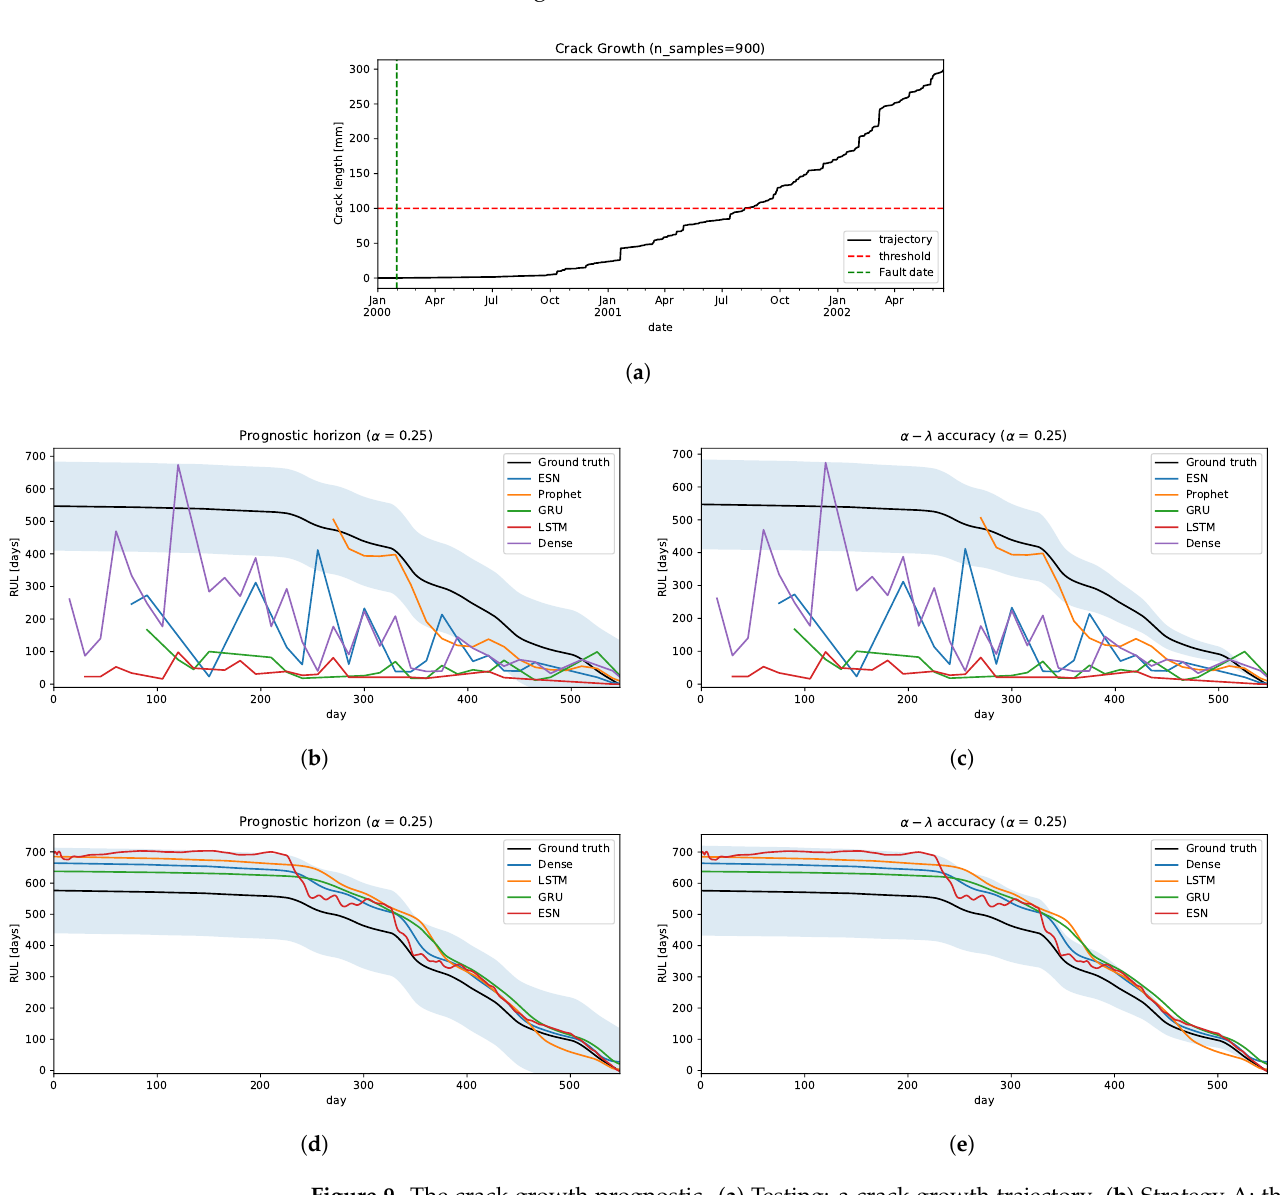
Figure 9. The crack growth prognostic. ( a ) Testing: a crack growth trajectory. ( b ) Strategy A: the prognostic horizon metric. ( c ) Strategy A: the α – λ accuracy metric. ( d ) Strategy B: the prognostic horizon metric. ( e ) Strategy B: the α – λ accuracy